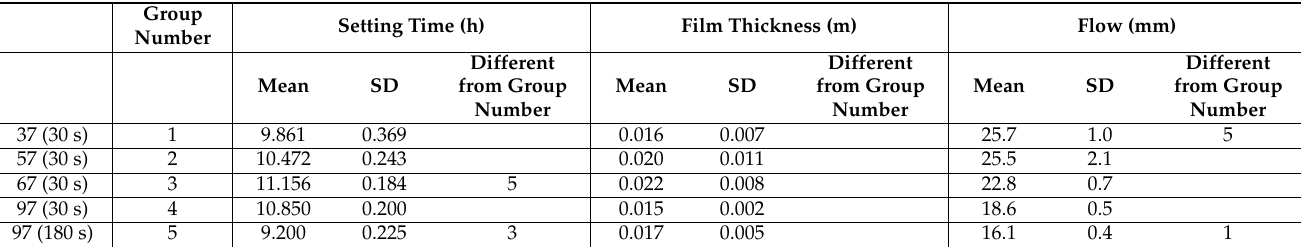
Table 3. Physical properties in accordance with ISO 6876 of AH Plus Bioceramic (means and standard deviations (SD)) after thermal treatment. Statistical analysis of setting time, film thickness, and flow for AH Plus Bioceramic was performed by Kruskal–Wallis test ( p < 0.05).